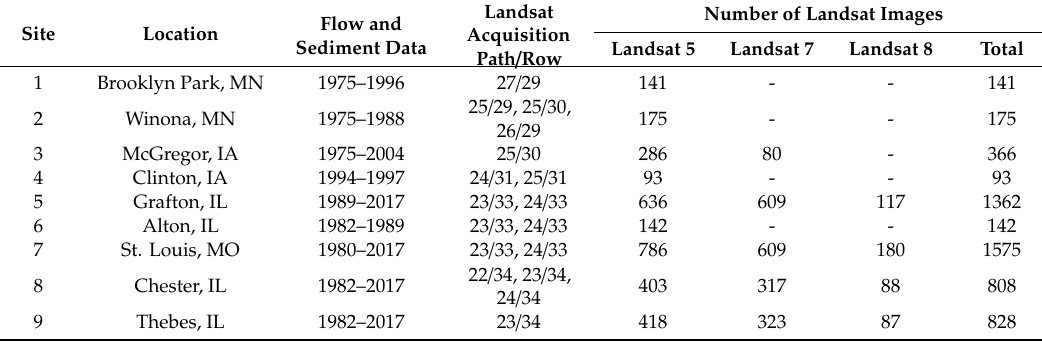
Table 2. Available Landsat images (5490 total) with corresponding sediment data for the Upper Mississippi River study sites.